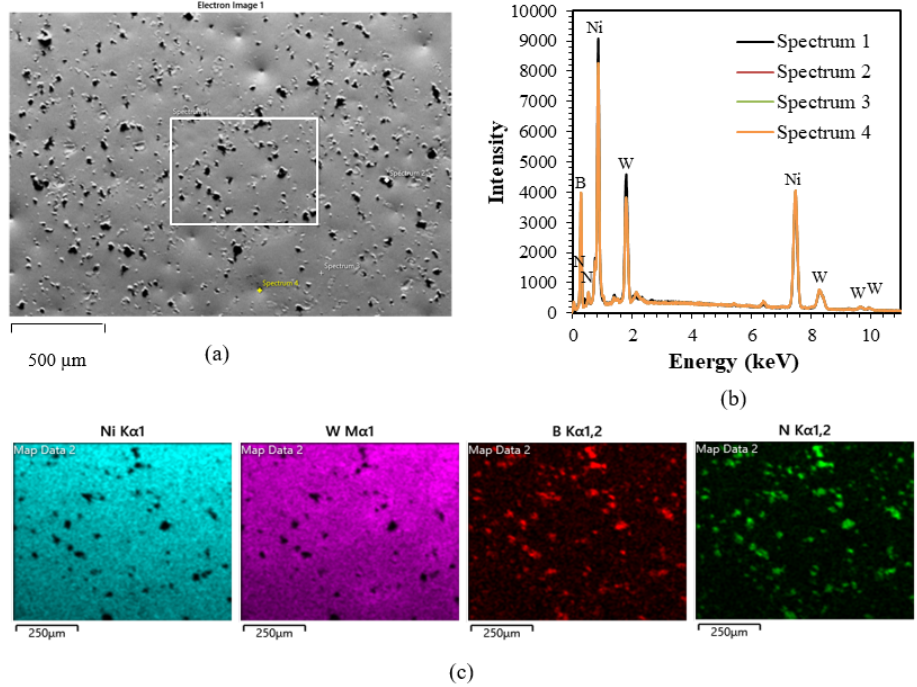
Figure 6. SEM micrograph ( a ), EDS spectra ( b ), and X-ray mapping ( c ) taken from the surface of the NiW–hBN coating; EDS map ofthe area is highlighted with a white rectangle in the SEM image. SEM micrograph, EDS spectra, and X-ray mapping (Figure 7) were taken from the surfaces of the electrodeposited NiW–SiC–hBN. The coating surface was crack-free with- out any delamination and coating elements were homogeneously distributed across the surface. As well, EDS spectra and X-ray mapping results suggest that the elemental com- position of the coatings Ni (~69.6 wt%), W (~9.3 wt%), Si (~8.6 wt%), C (~5.1 wt%), B (~5.8 wt%), and N (~1.1 wt%) were homogeneously distributed throughout the surface.